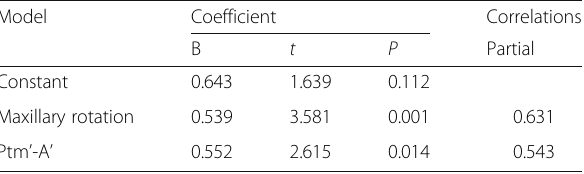
Table 3 Multiple linear regression analysis of the influence on the x -component of vector A in the FM group